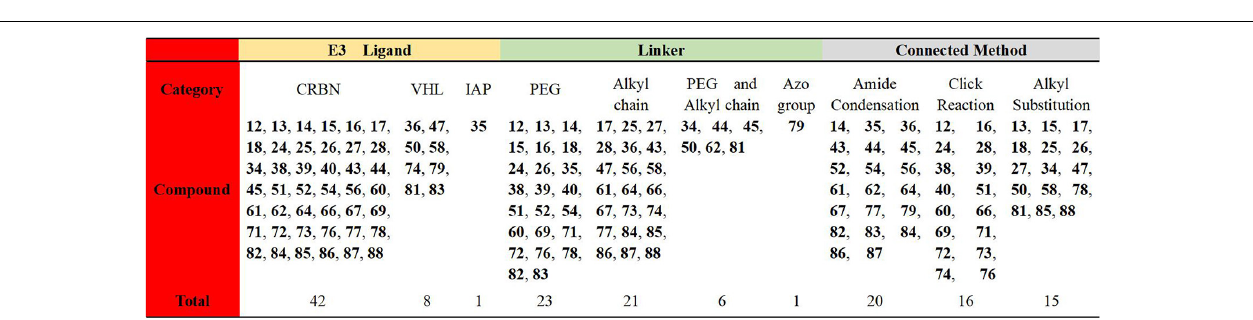
FIGURE 16 | Summary and comparison of the 51 PROTACs mentioned in this